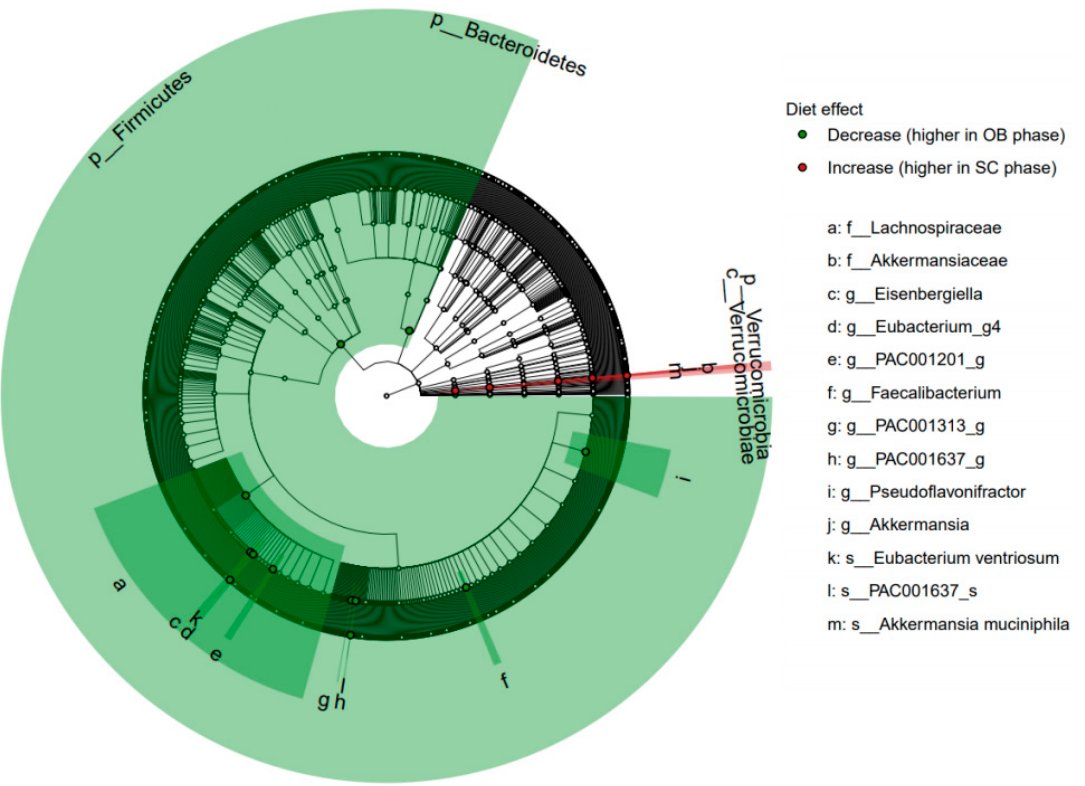
Figure 4. Cladogram for all subjects and 17 taxa showing significant microbiota changes between the observation (OB) and semi ‐ controlled diet (SC) phases (relative increases in the SC phase in red, decreases in green). Bacteria that show a significant change (FDR < 0.05) are highlighted with a node circle and labelled with text and clade. Taxonomic level indicated by letter preceding the bacterial descriptor from genus, ‘s_’ to phyla, ‘p_’.